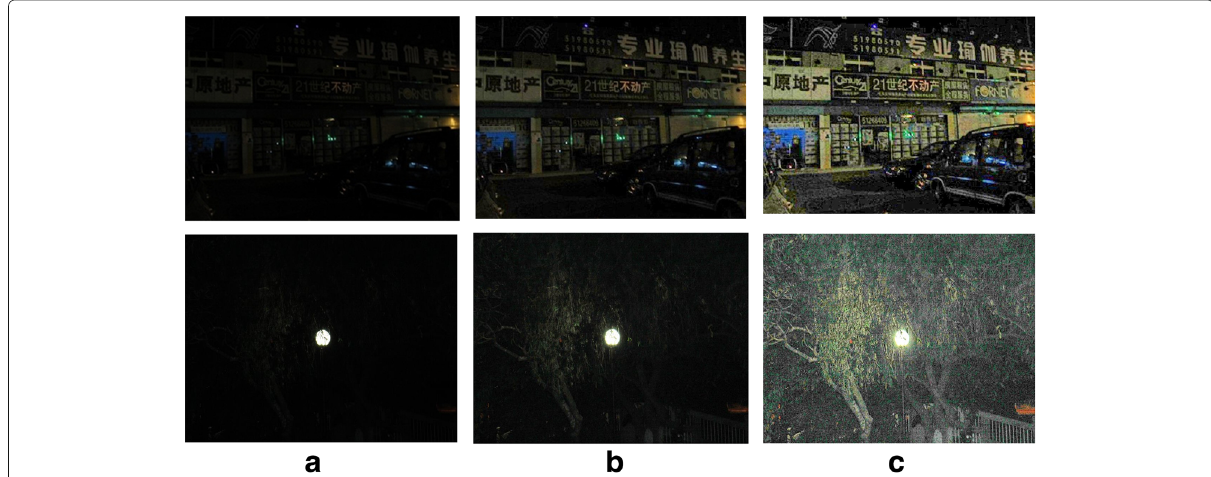
Fig. 10 Comparison of the proposed method with negative imaging dark channel-based method [20]. a Input images. b Enhanced images with negative imaging dark channel-based method [20]. c Enhanced image with the proposed